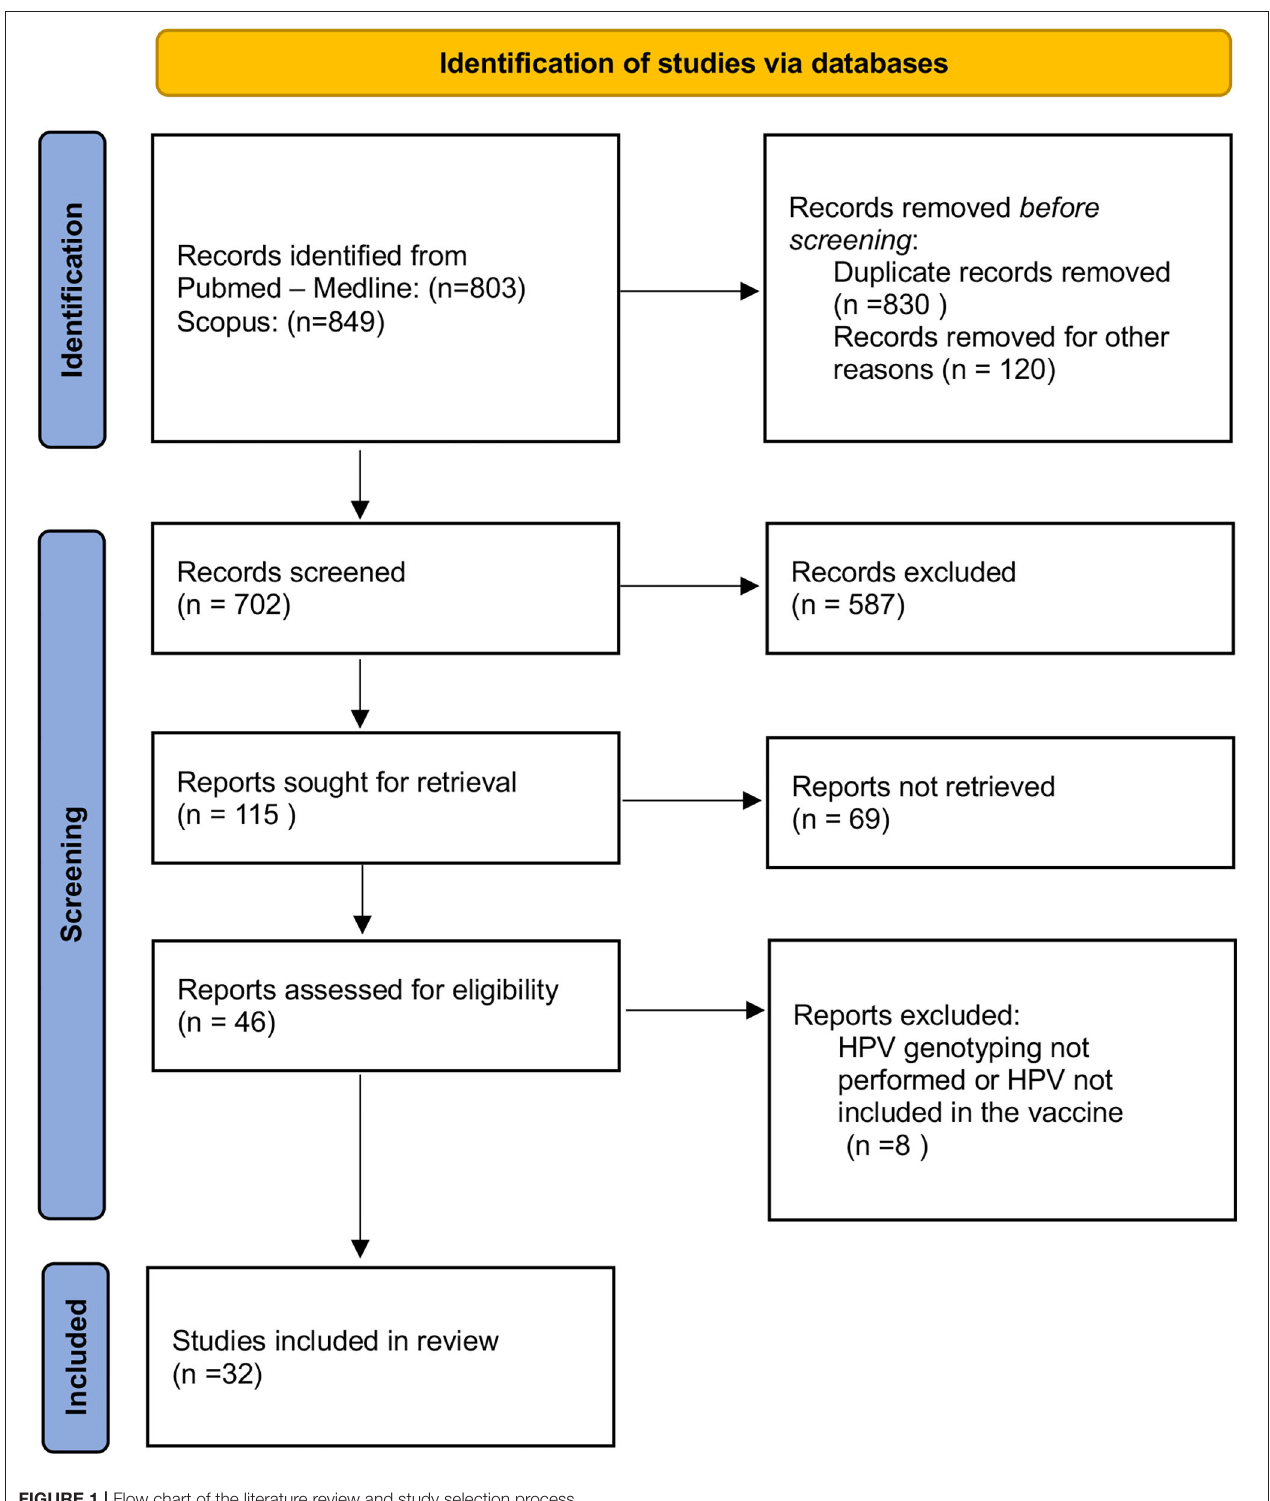
FIGURE 1 | Flow chart of the literature review and study selection process.